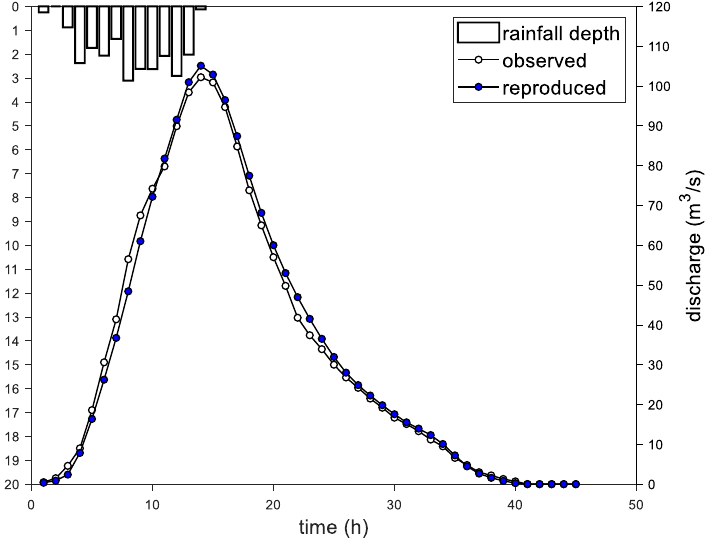
Figure 3. Comparison of observed hydrograph and hydrograph reproduced by the proposed procedure for selected storm (in the Almond and Almondell basin).